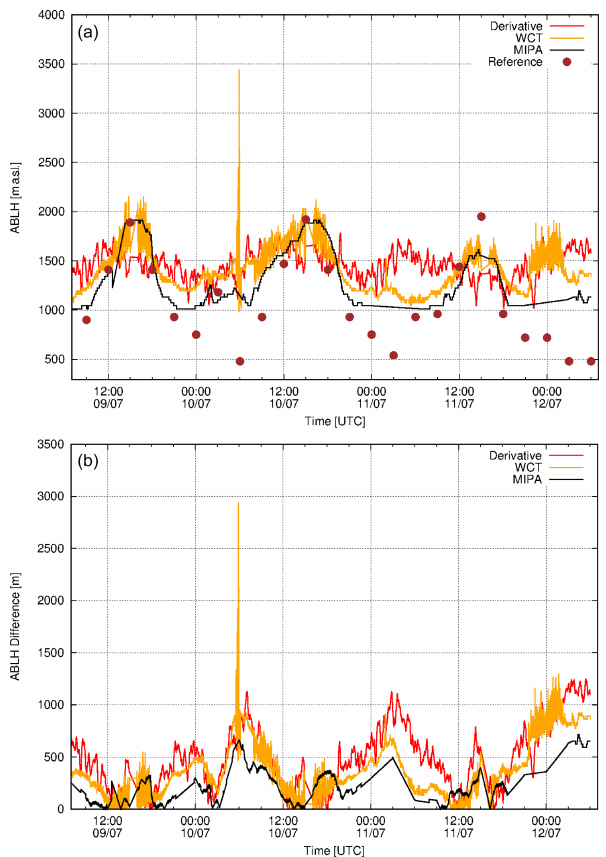
Figure 6. (a) ABLH retrieved during the 72h EARLINET exer- cise (9–12 July 2012) for Évora. Black, red and yellow lines show the ABLH retrieved from 1064nm high-resolution total attenuated backscatter time series applying MIPA, derivative and WCT algo- rithms, respectively. Brown circles are the reference ABLHs re- trieved from atmospheric temperature and pressure profiles pro- vided by GDAS forecasts. (b) Absolute differences of the retrieved ABLHs withe respect to the reference. The original time resolution of GDAS forecasts data is 3h. They have been interpolated at the lidar data time resolution (30s).